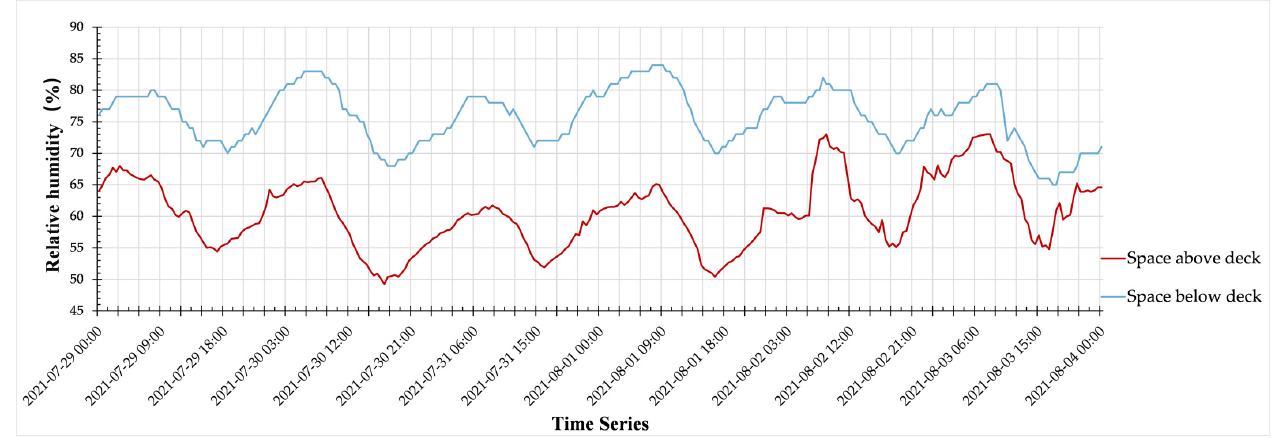
Figure 8. Relative humidity in the ship between 29 July and 4 August 2021.